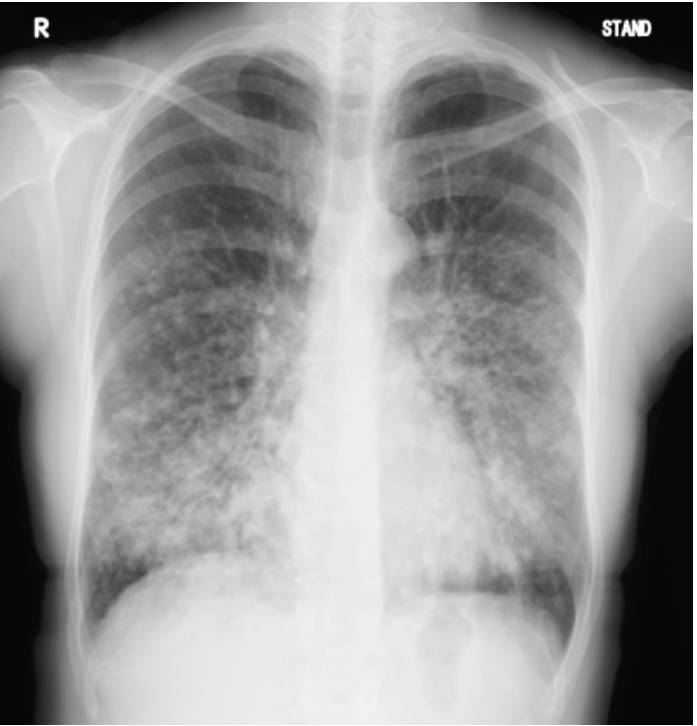
Figure 1. A chest radiograph of the patient at 39 years of age. Diffuse nodules, consolidation, and bronchial wall thickening predominantly in the lower lung fields are observed.